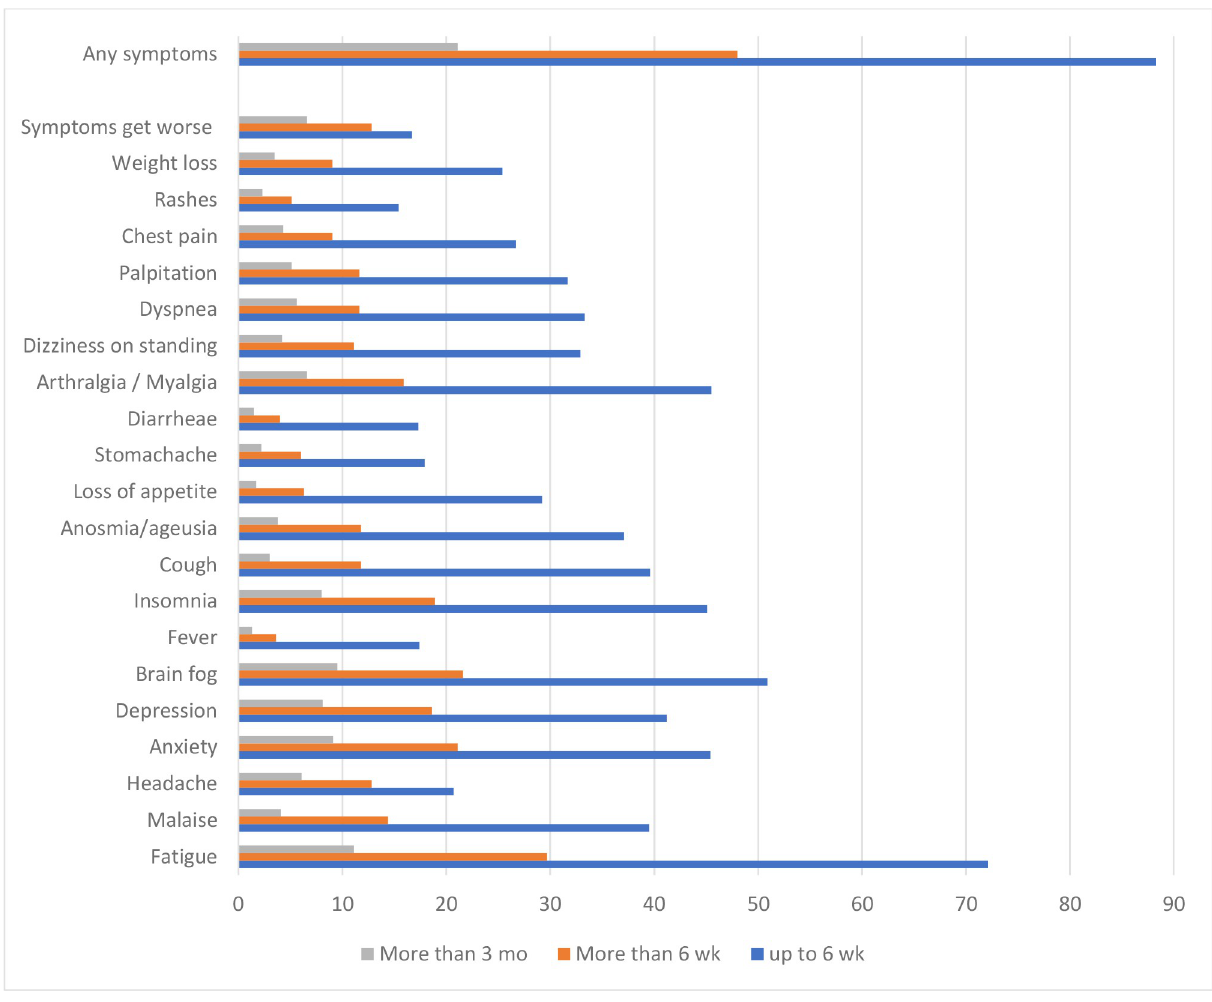
Fig 1. Post COVID symptoms at different duration.